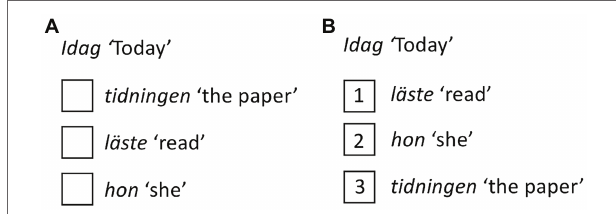
FIGURE 1 | Sentence completion task (SCT). Sentences were presented with the adverbial on top followed by words or phrases below (A) . By inserting a number in the empty boxes, the order of the words or phrases shifted as illustrated in (B) . See Supplementary Materials for a full list of stimuli sentences.